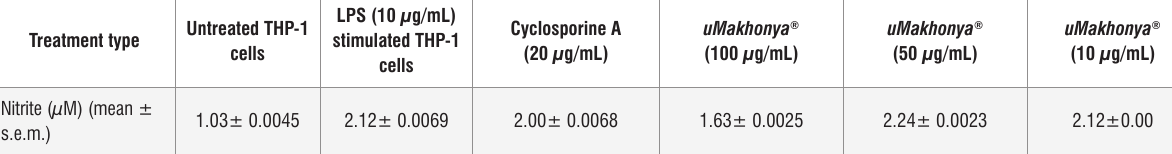
Table 2: Evaluation of nitrite as a measure of nitric oxide secretion from LPS stimulated THP-1 monocytes. LPS (10 µg/mL) Untreated THP-1 Treatment type stimulated THP-1 cells